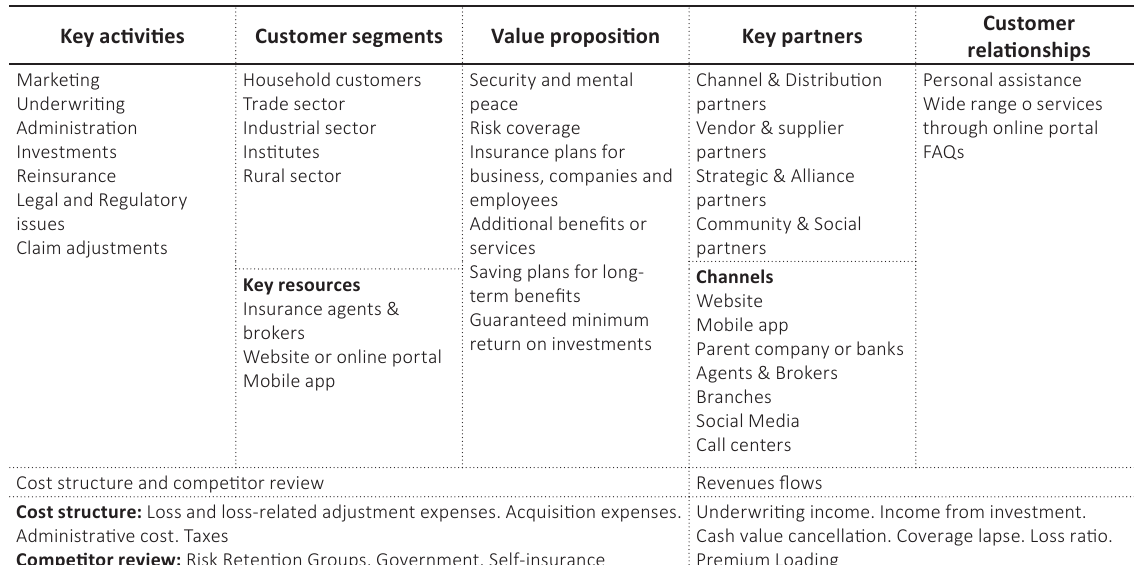
Table 3. CANVAS models for LIFE insurance